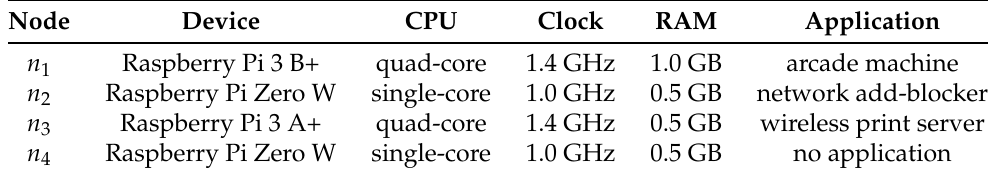
Table 1. Cluster